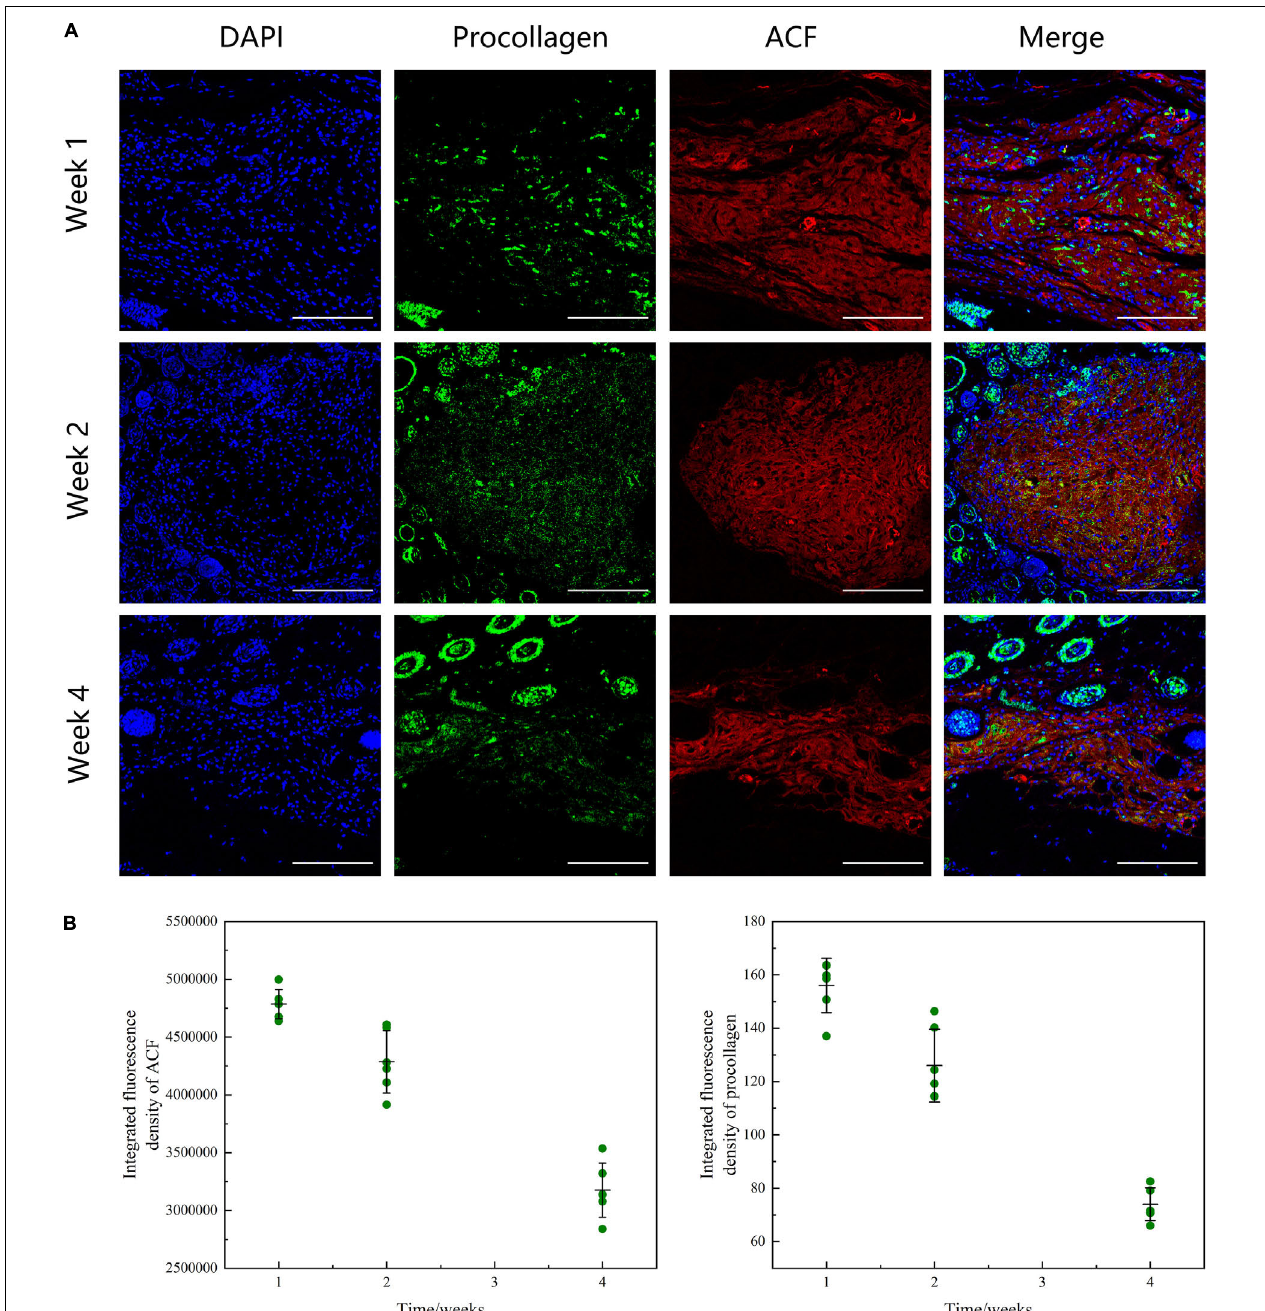
FIGURE 9 | Histological evaluation of ACF in vivo remodeling process. (A) Immunofluorescence staining of AF647 labeled-ACF and procollagen. ACF underwent a degradation process from weeks 1 to 4 and procollagen expression in ACF implant was maximal at week 1 and then decreased from weeks 2 to 4. (B) Semi-quantitative analysis of ACF retention and procollagen expression in ACF. Scale bar = 200 µ m. P (ACF retention at week 1–2) = 0.002, F (ACF retention at week 1–2) = 0.121; P (ACF retention at week 1–4) = 1.810E-05, F (ACF retention at week 1–4) = 0.767; P (ACF retention at week 2–4) = 3.990E-08, F (ACF retention at week 2–4) = 0.202. P (procollagen at week 1–2) = 0.002, F (procollagen at week 1–2) = 0.542; P (procollagen at week 1–4) = 5.720E-06, F (procollagen at week 1–4) = 0.103; P (procollagen at week 2–4) = 1.137E-08, F (procollagen at week 2–4) = 0.286.